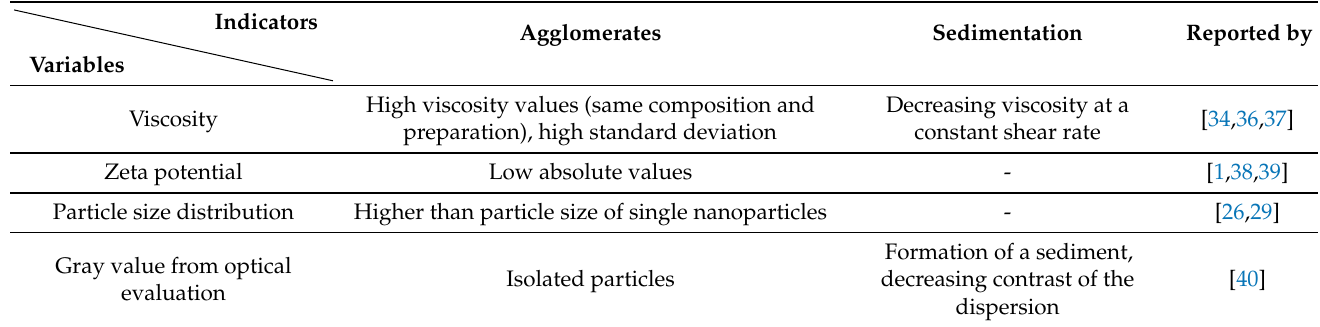
Table 1. Quantities determining the stability of